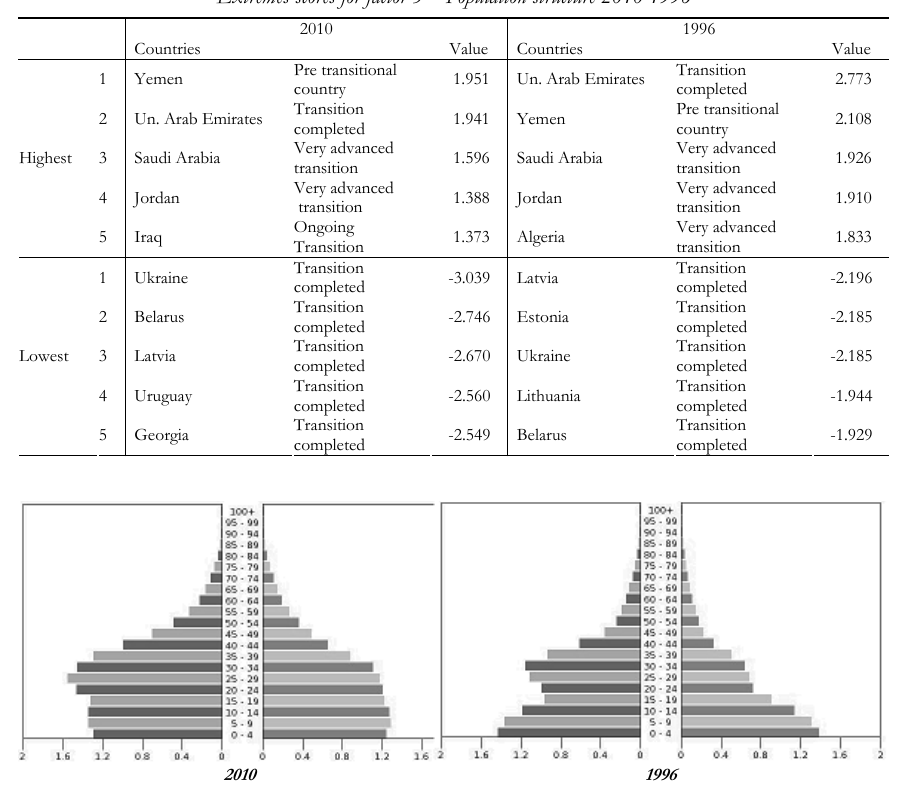
Extremes scores for factor 3 – Population structure 2010-1996